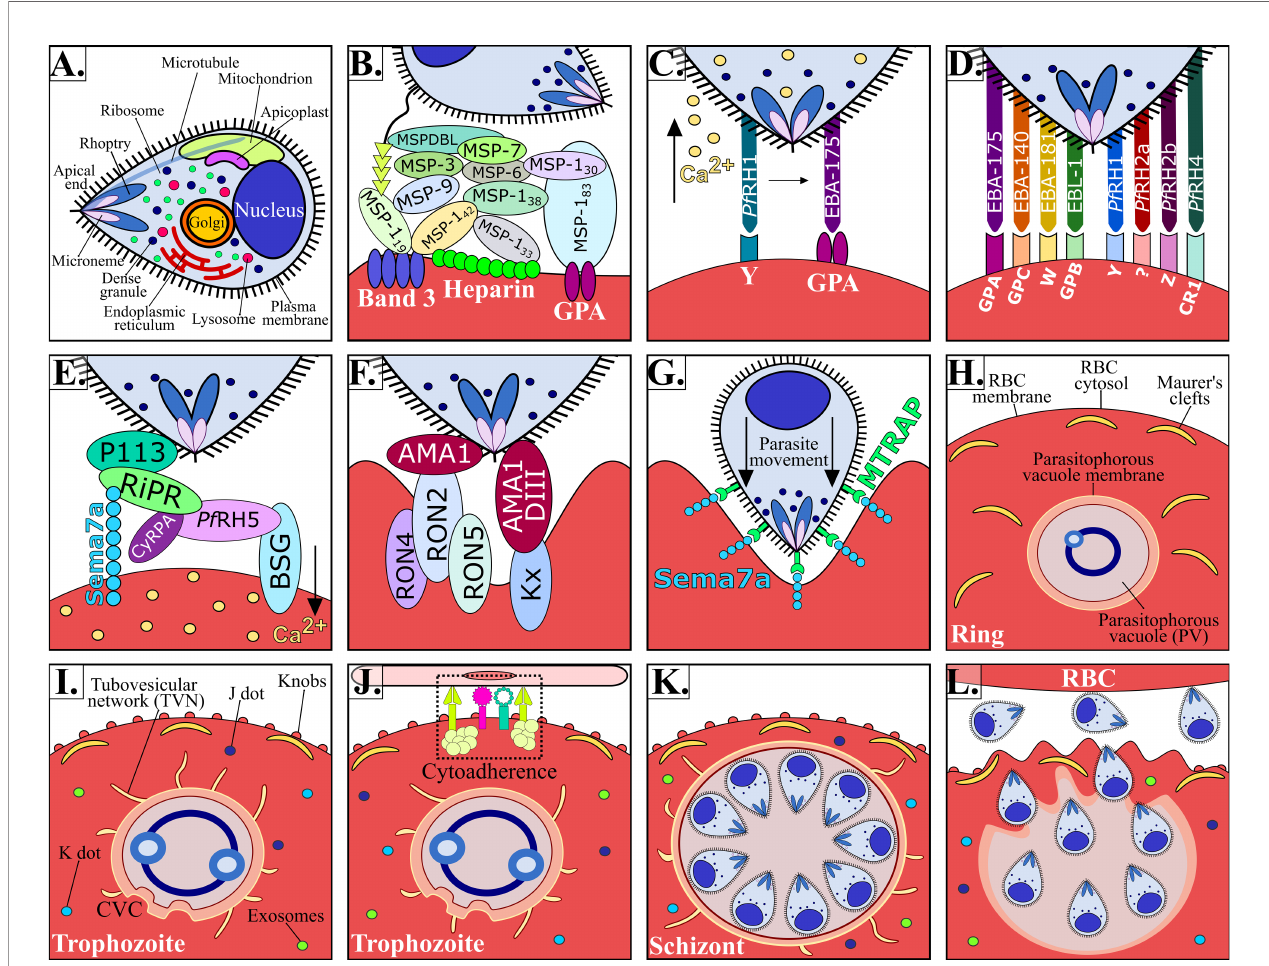
FIGURE 2 | P . falciparum Mrz invasion and major changes induced in infected RBC. (A) P. falciparum Mrz (B – G) parasite ligands and RBC receptors involved in initial contact, apical reorientation and tight junction formation during Mrz invasion of RBC. (H) P. falciparum ring stage growing inside the PVM, representing the interface between parasite and host cytoplasm. Maurer ’ s clefts are fl at and elongated membrane vesicles; they are mobile in iRBC cytoplasm during early parasite stages. (I) P. falciparum trophozoite stage. Maurer ’ s clefts are attached to membrane skeleton during mature parasite stages. Tubovesicular network (TVN) extending from the PVM into iRBC cytoplasm. Caveola vesicle complex (CVC) containing P. falciparum antigens which could be involved in the transport and release of speci fi c parasite antigens from the iRBC and in plasma protein uptake. J dots, K dots and exosomes are membrane structures that traf fi c some parasite proteins (e.g. Pf EMP-1) through iRBC cytoplasm. Knobs covering the iRBC surface during late parasite stages. (J) P. falciparum cytoadherence mediated by the interaction between variant surface antigens and host receptors (K) P. falciparum schizont stage. (K) iRBC rupture and Mrz release. (L) Mrz release and RBC